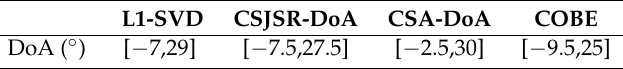
Table 2. Result of the prototype system experiment. CSA, compressive sensing array; COBE, compressive bearing